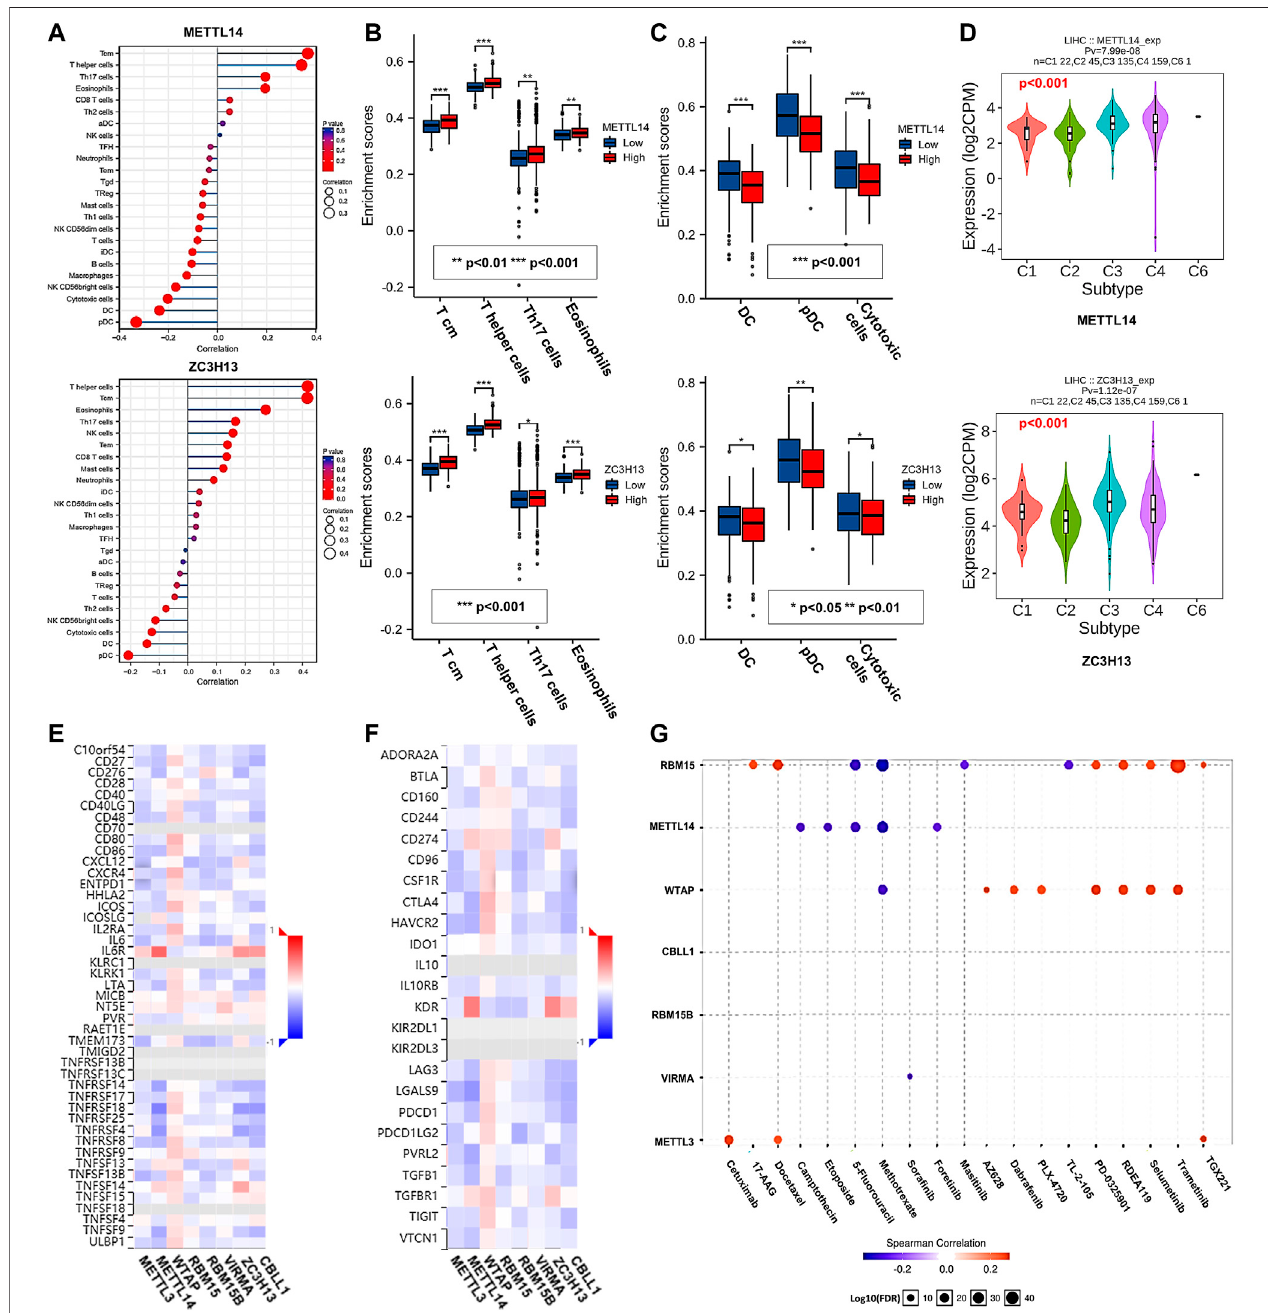
FIGURE 9 | Correlations between the m 6 A writer complex and tumor immunology in HCC. (A) Relationship between the m 6 A writer complex and immune cell in fi ltrationinHCC.Boxplotsshowimmunecellspositively (B) andnegatively (C) correlatedwiththem 6 AwritercomplexinHCC. (D) Correlationsbetweenthem 6 Awriter complex and immune subtypes in HCC (TISIDB). Kruskal – Wallis test, p < 0.05 was regarded as statistically signi fi cant. C1: wound healing, C2: IFN- γ dominant, C3: in fl ammatory, C4: lymphocyte depleted, C5: immunologically quiet, C6: TGF- β dominant. Heatmaps show correlations between the m 6 A writer complex and the expression of immunostimulators (E) and immunoinhibitors (F) in HCC (TISIDB). (G) Correlations between the m 6 A writer complex and drug sensitivity in immune or targeted therapies (GSCALite). Red and blue represent positive and negative correlations, respectively.